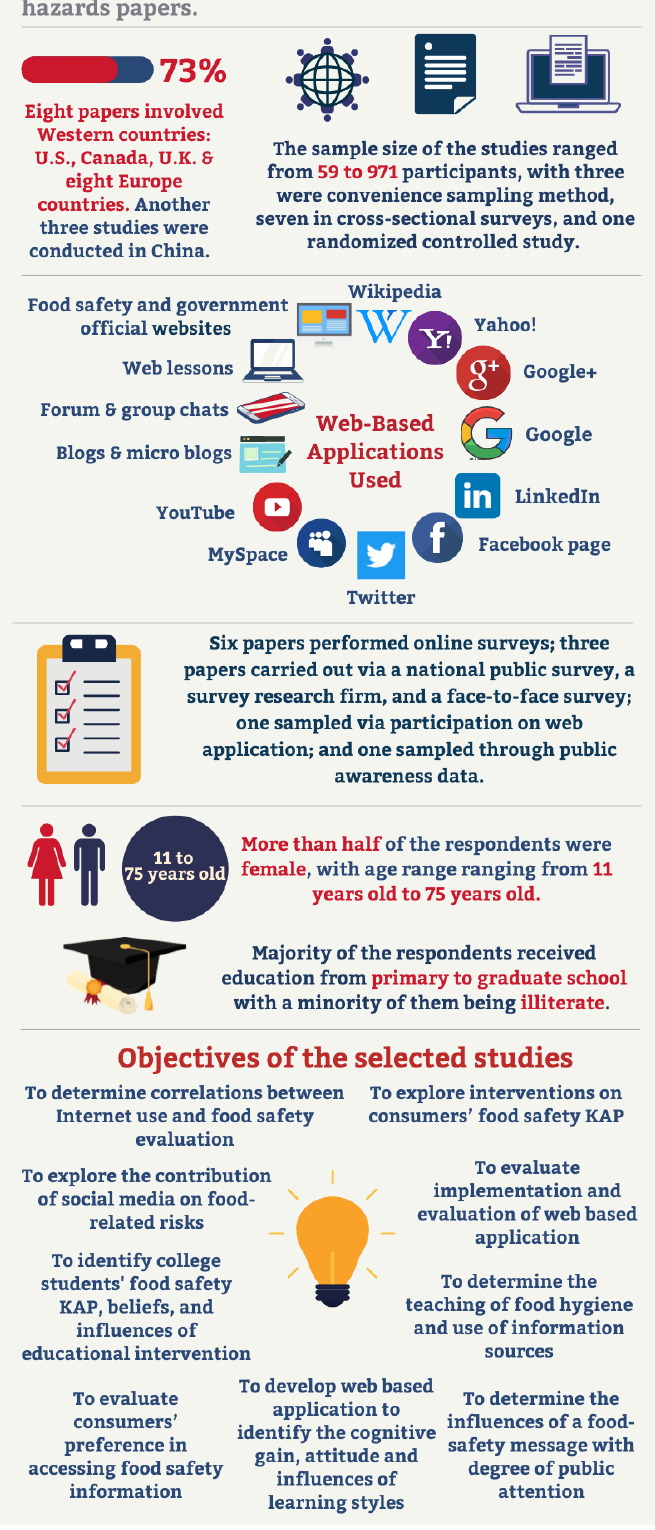
Figure 2. The general characteristics of the selected studies.